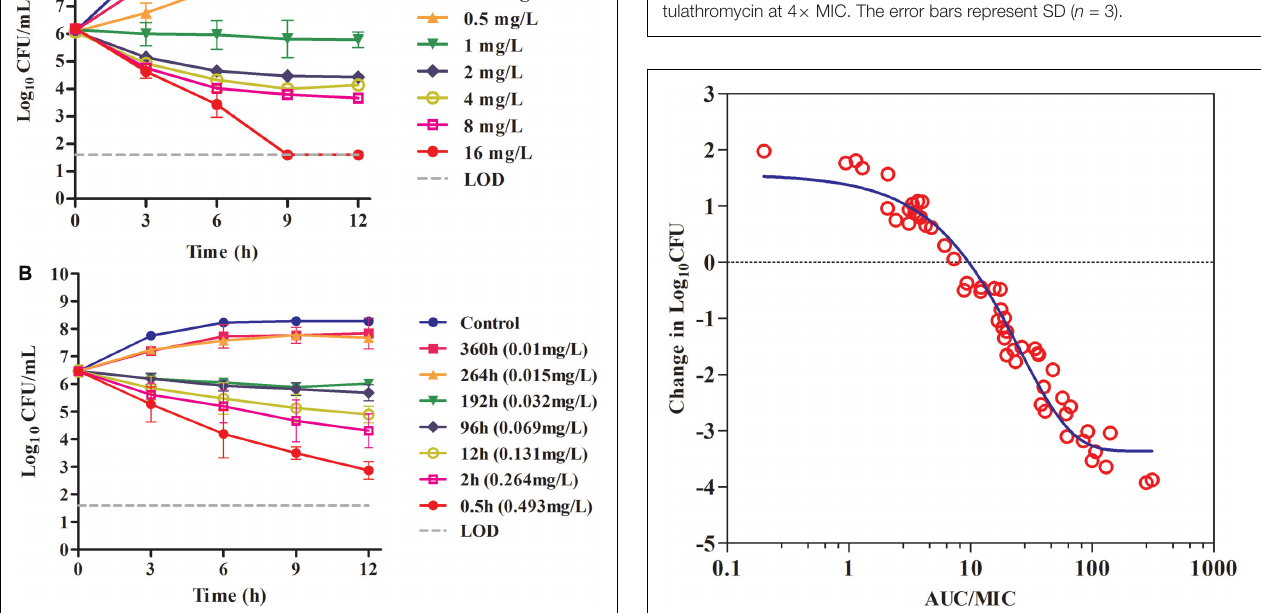
FIGURE 2 | (A) In vitro time–kill curves of tulathromycin against S. suis ATCC 43765 in the MHB medium (MIC MHB = 1 µ g/mL); (B) ex vivo inhibition of bacterial growth in porcine serum before and after IM administration of tulathromycin (MIC serum = 0.031 µ g/mL). Numerical values on the right for each panel are tulathromycin concentrations in serum.